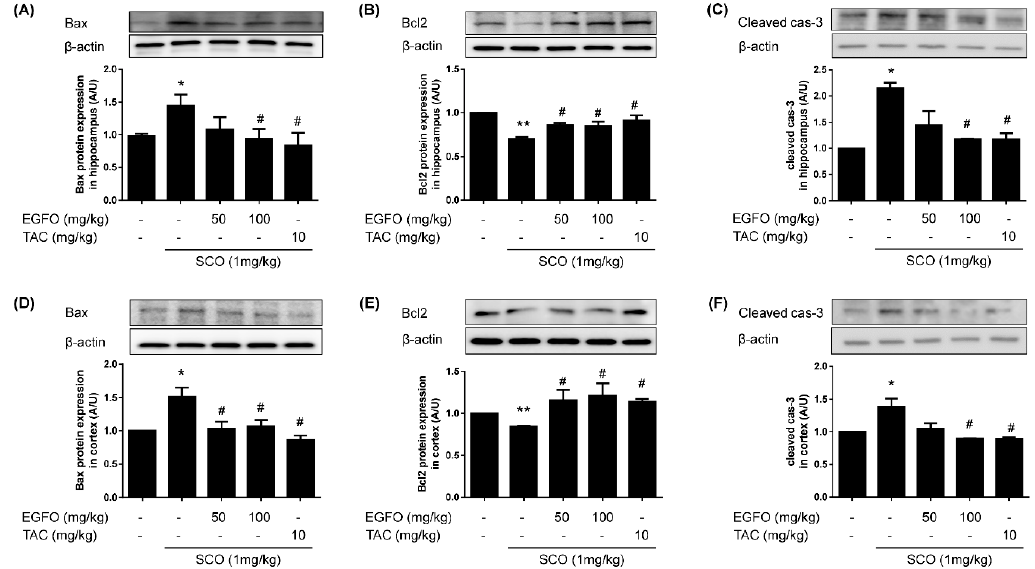
Figure 6. Effect of EGFO extract on the expression of apoptosis-related proteins in mice with scopolamine-induced memory impairments . Lysed hippocampal and cortical tissues performed Western blotting with anti-Bax ( A and D ), Bcl2 ( B and E ), and cleaved caspase-3 ( C and F ) antibodies. Levels of expression were normalized to β -actin. Bar graphs represent the relative intensity in each band. Values are expressed as the mean ± SEM. ( n = 7/group). * p < 0.05, ** p < 0.01 vs CONT group, # p < 0.05 vs. SCO group. CONT: Normal control; SCO: Scopolamine; EGFO: Elaeagnus glabra f. oxyphylla; TAC: Tacrine.